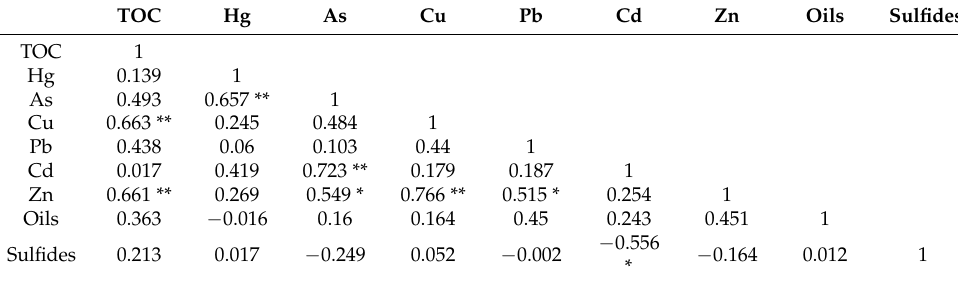
Table 3. Correlation analysis for HMs, TOC, Oils, and sulfides in sediments. TOC Hg As Cu Pb Cd Zn Oils Sulfides